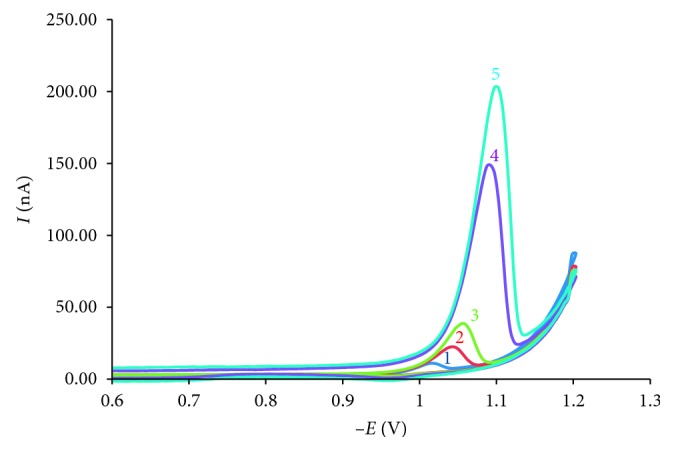
Cyclic voltammograms for 10−6 mol·L−1 AO in BR buffers of different scan rates (mV·s−1): (1) 10; (2) 50; (3) 100; (4) 500; (5) 700; Eacc = 0 V, tacc = 30 s.